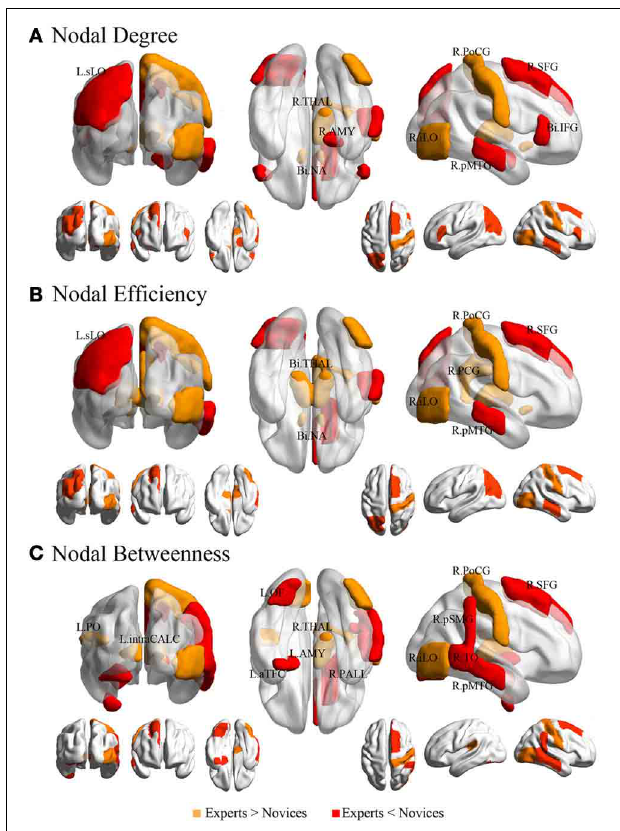
FIGURE 5 | Brain regions showing significant differences in each nodal metric between experts and novices. Regions with significant group differences, including nodal degree (panel A ), nodal efficiency (panel B ), and nodal betweenness (panel C ), were rendered using BrainNet Viewer (http://www.nitrc.org/projects/bnv/). See Table 4 for detailed information. R, right; L, left; Bi, bilateral; PoCG, postcentral gyrus; SFG, superior frontal gyurs; IFG, inferior frontal gyrus; pMTG, posterior division of middle temporal gyrus; sLO, superior division of lateral occipital cortex; iLO, interior division of lateral occipital cortex; THAL, thalamus; AMY, amygdala; NA, nucleus accumbens; PCG, posterior cingulate gyrus; pSMG, posterior division of supramarginal gyrus; OF, occipital fusiform gyrus; aTFC, anterior division of temporal fusiform cortex; PALL, pallidum; PO, parietal operculum cortex; TO, temporooccipital part of middle temporal gyrus; intraCALC, intracalcarine cortex.